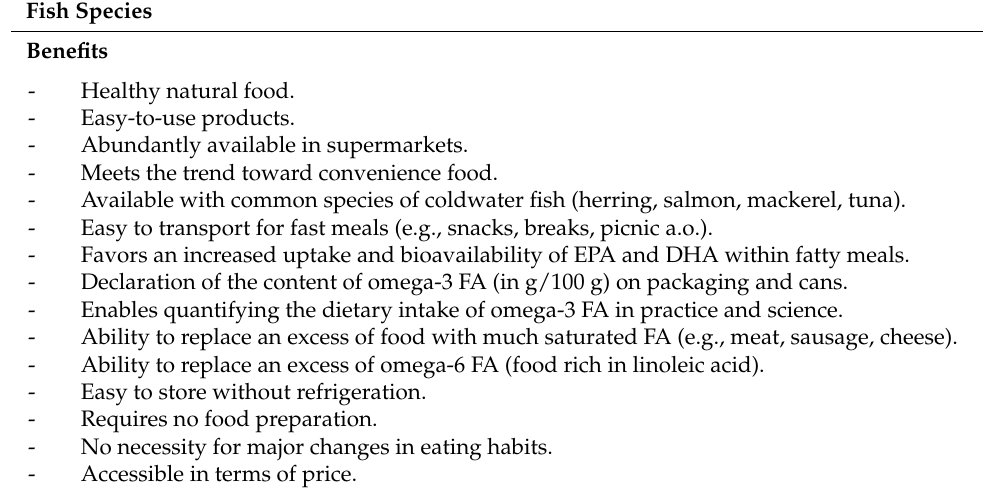
Table 3. Benefits or disadvantages of canned cold-water fish as sources of omega-3